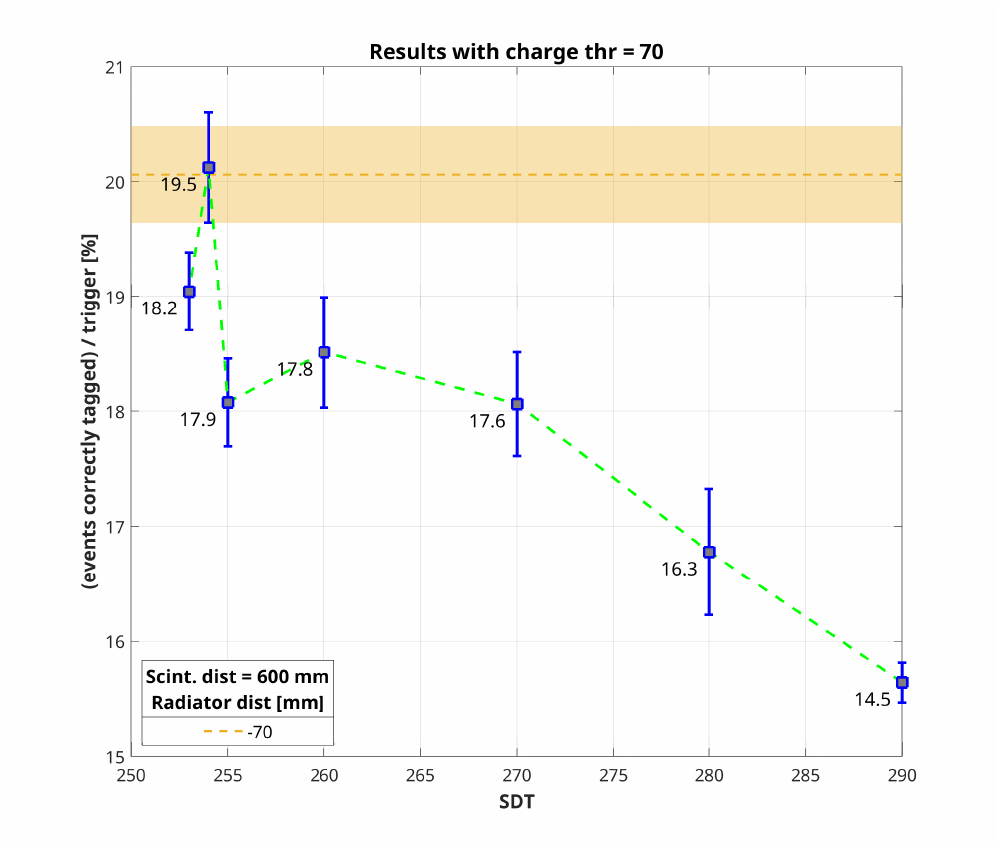
Figure 8. Comparison between the percentage of correctly tagged events with respect to the number of external triggers and the geometric efficiency calculated with a Monte Carlo simulation (dark yellow horizontal dashed line). This plot refers to values reported in Table 4, with charge threshold equal to 70 a.u. Values reported in the plot near the squared markers correspond to the net rate of correctly-tagged events, i.e., rate UP –rate DOWN in Table